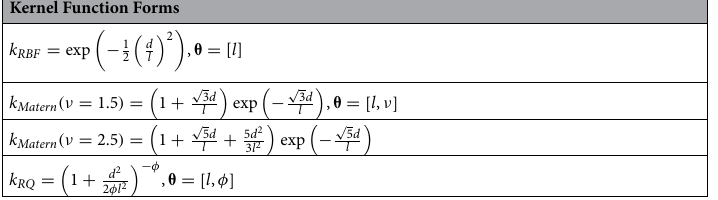
Kernel Function